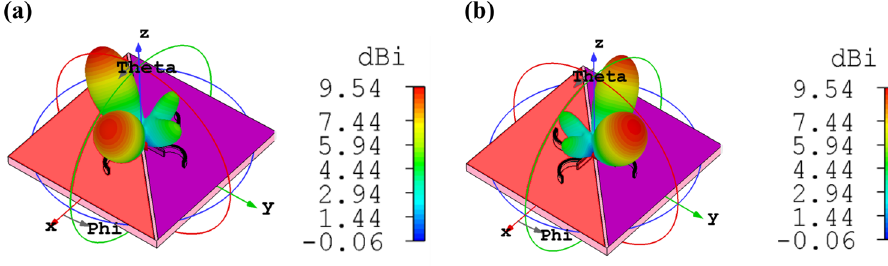
Figure 13. 3D radiation patterns of bidirectional cross dipole nano-antenna when ( a ) µ 1 = 0 eV , µ 2 = 0 .51eV and ( b ) µ 1 = 0.51eV , µ 2 = 0 eV .